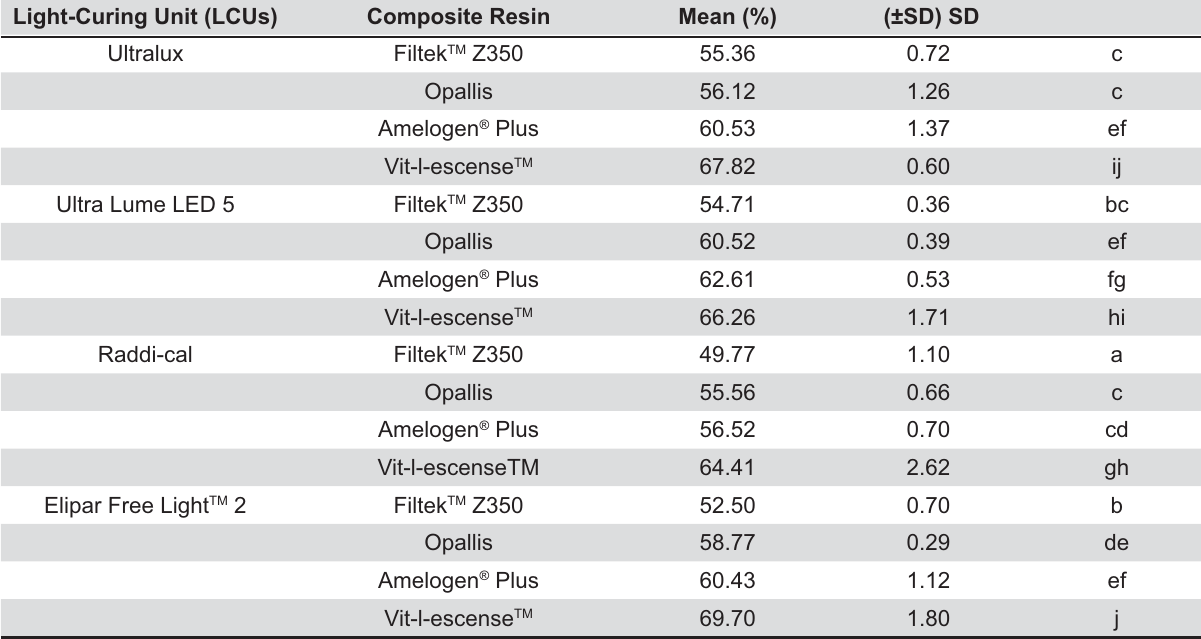
Table 1- Averages and standard deviations (±SD) for the degree of conversion Light-Curing Unit (LCUs) Composite